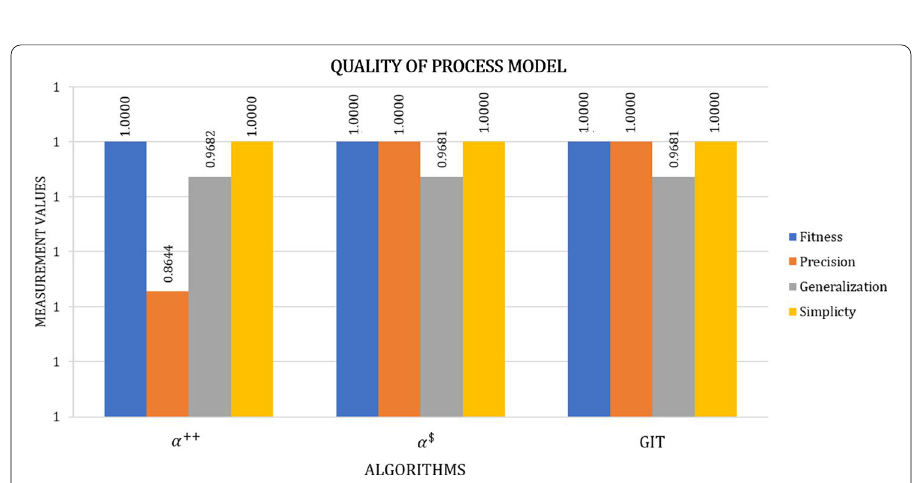
Fig. 5 Result comparison between the previous methods and the proposed